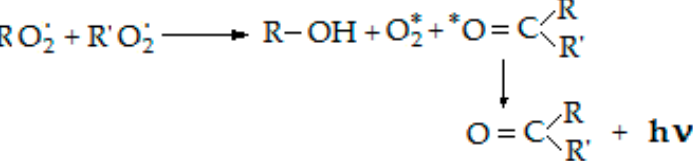
Figure 2. CL mechanism describing the generation of measuring photons during the degradation of polymers.